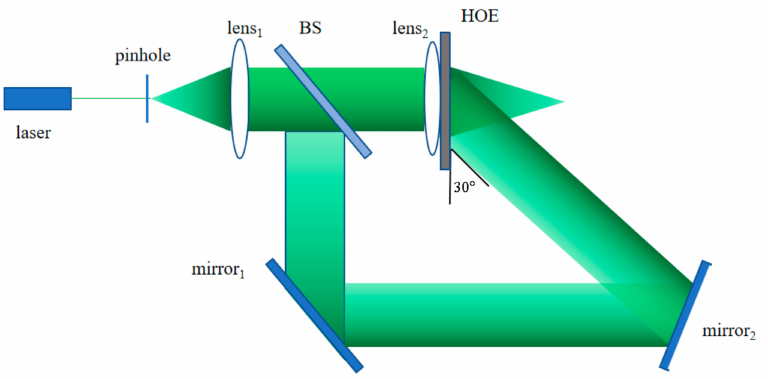
Figure 9. Optical system for holographic optical element (HOE) recording.